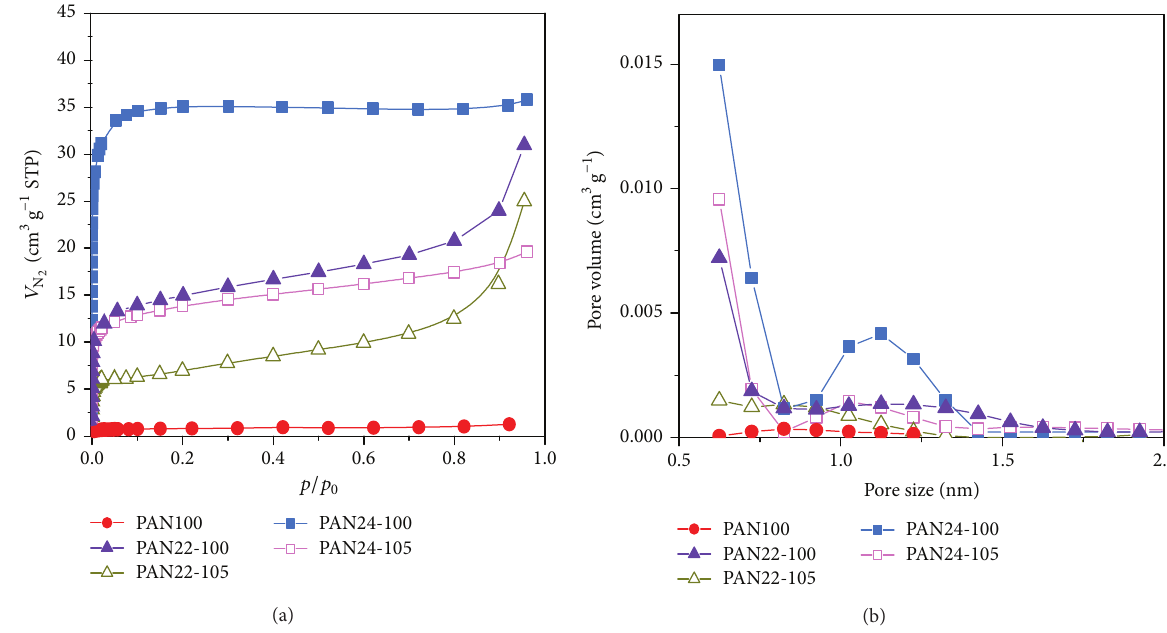
Figure 3: N 2 adsorption isotherms (a) and pore size distribution (b) of PAN-based carbons.